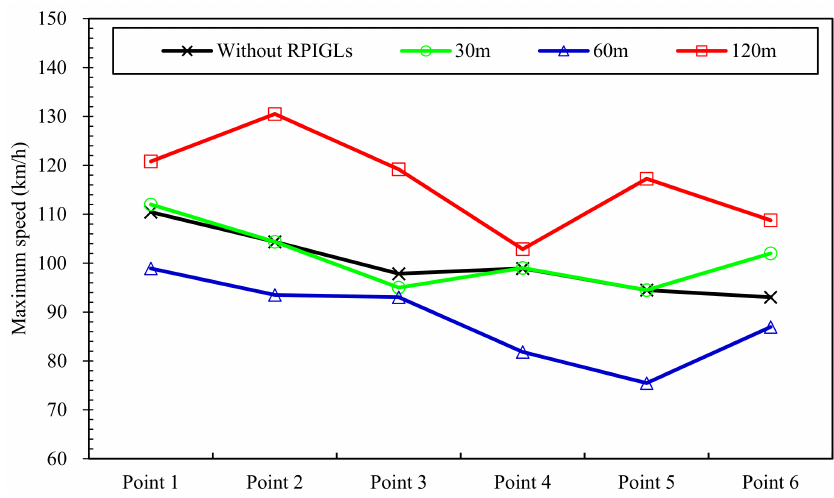
Figure 9. Maximum speeds of vehicles controlled by RPIDLs with different group lengths.